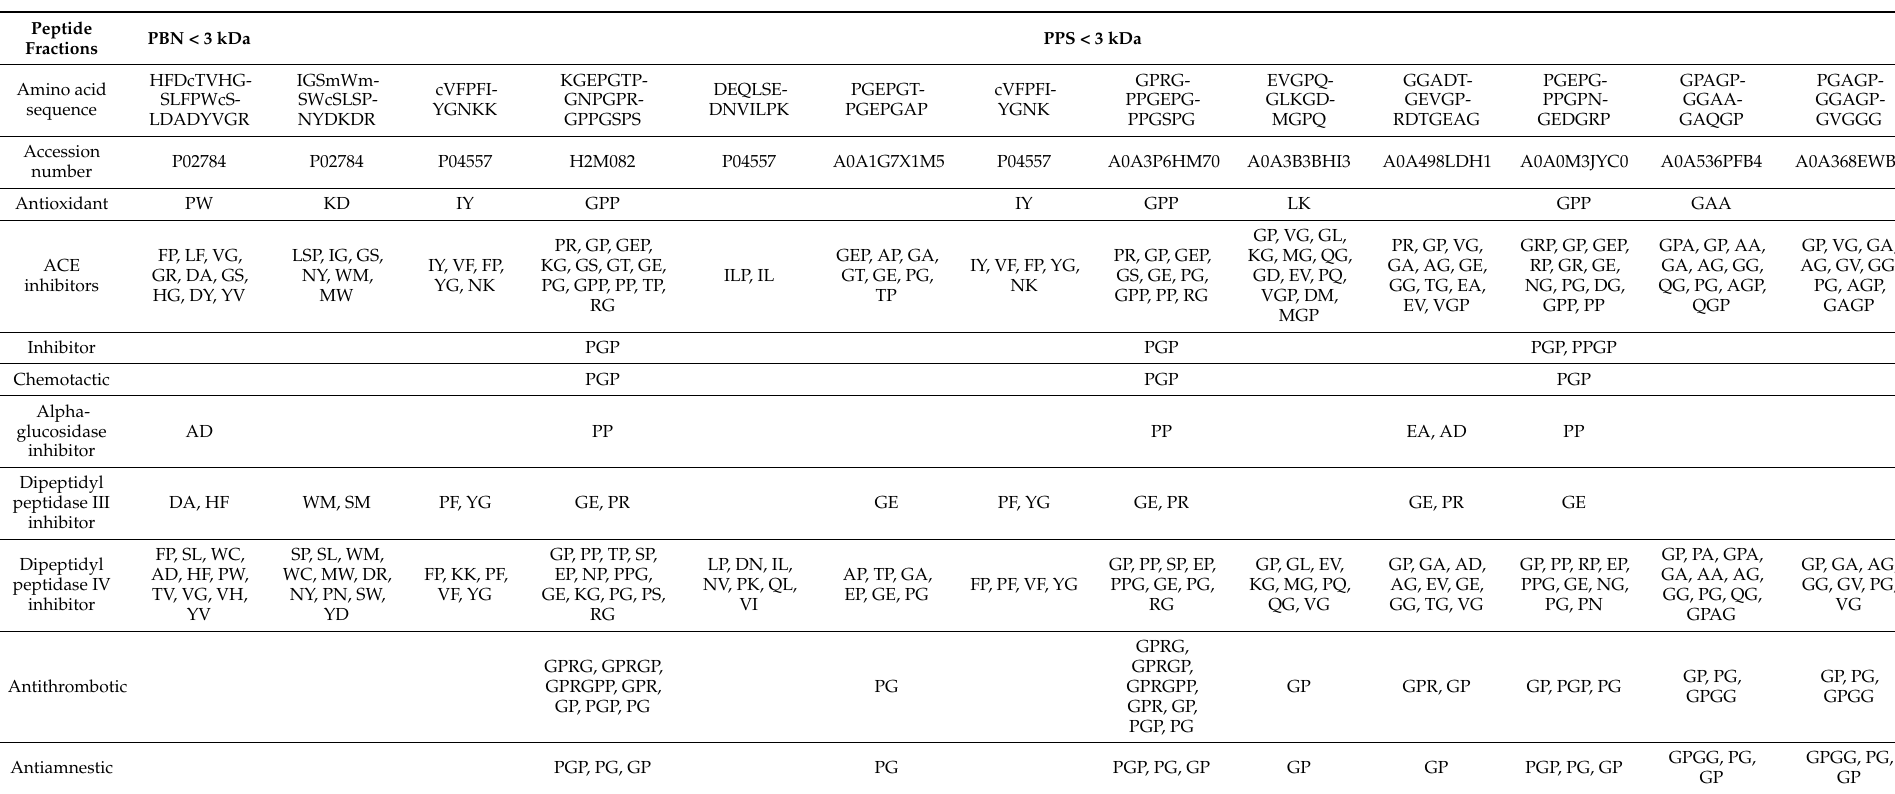
Table 3. Prediction of bioactive properties of peptides in the PBN and PPS fractions of < 3